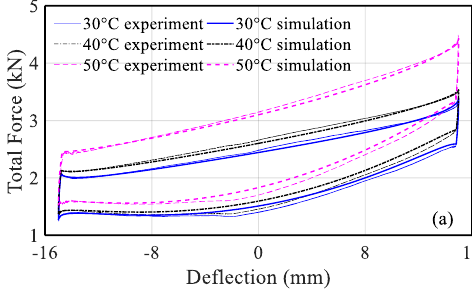
Figure 4. Comparisons of experimental and simulated total force-deflection ( a ) and total force-velocity ( b ) relationships at different temperatures (0.5 Hz).